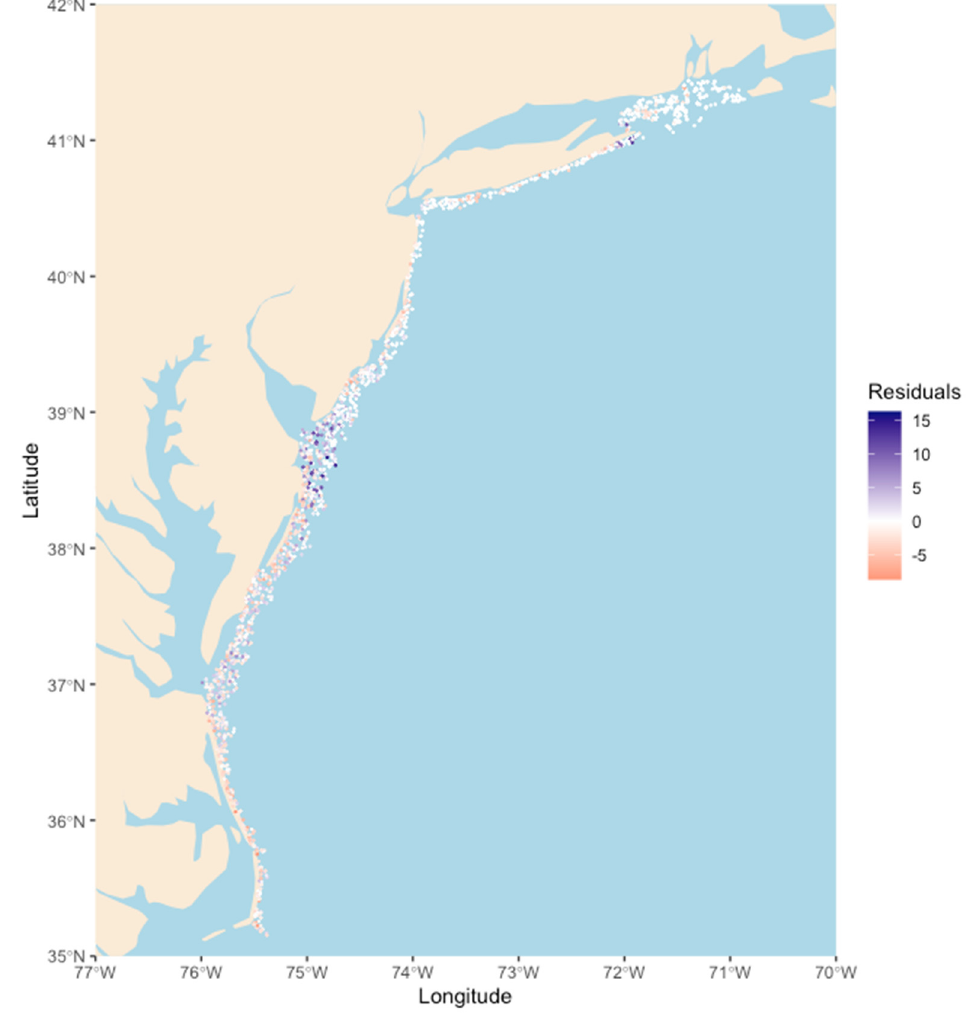
Figure A6. Map of residuals from delta SAR mixed model fitted to NEAMAP weakfish survey data. Blue indicates positive, red indicates negative, and color darkness is proportional to the value of residuals.